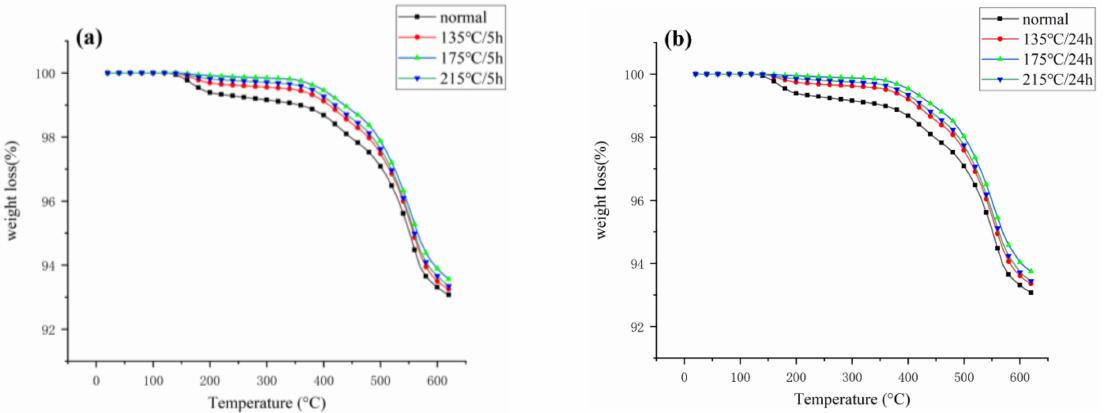
Figure 7. TGA curve of the coil bobbin after ( a ) 5 h and ( b ) 24 h of baking. After baking at the same temperature for 5 h and 24 h, the TGA curve of the coil